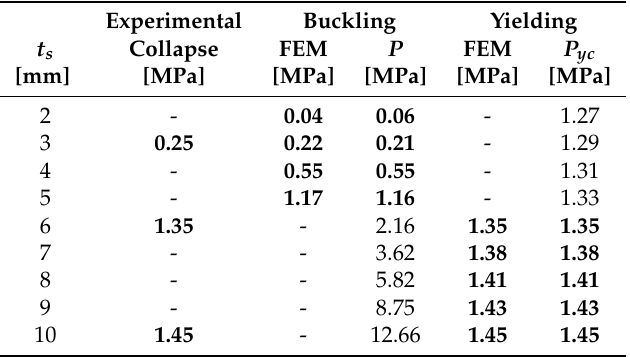
Table 10. Comparison between theoretical and FEM data.